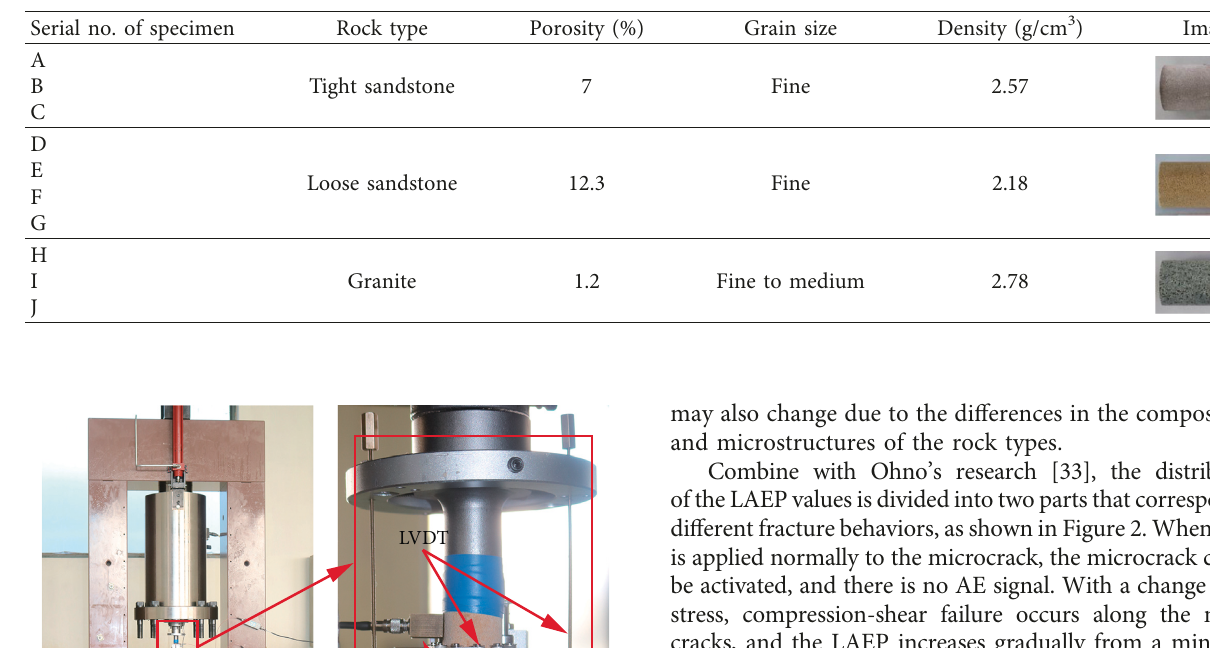
Table 1: Basic properties of the rock